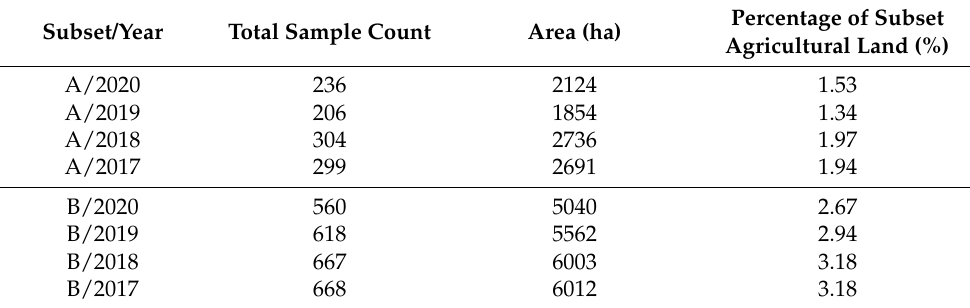
Table 4. Training and test sample count and area covered per subset agricultural